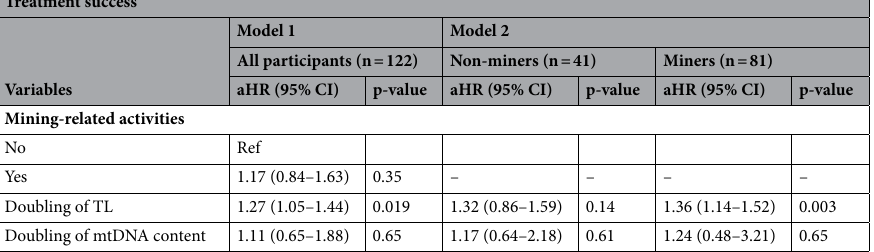
Table 4. Multivariable cox regression analysis of predictors associated with pulmonary tuberculosis treatment success among artisanal miners and relatives. Hazard ratios and p-values were computed by Cox regression and expressed for a doubling in TL and mtDNA content at baseline. Model 1 includes all participants. Model 2 stratifies participants by mining related-activities. All models are adjusted for age, sex, tobacco smoking, TB category, years working in artisanal mining (when applicable), HIV-infection status and body mass index. Model 1 also adjusted for Xpert MTB/RIF result. TL leukocyte telomere length, mtDNA mitochondrial DNA, aHR adjusted hazards ratio, Ref. reference.